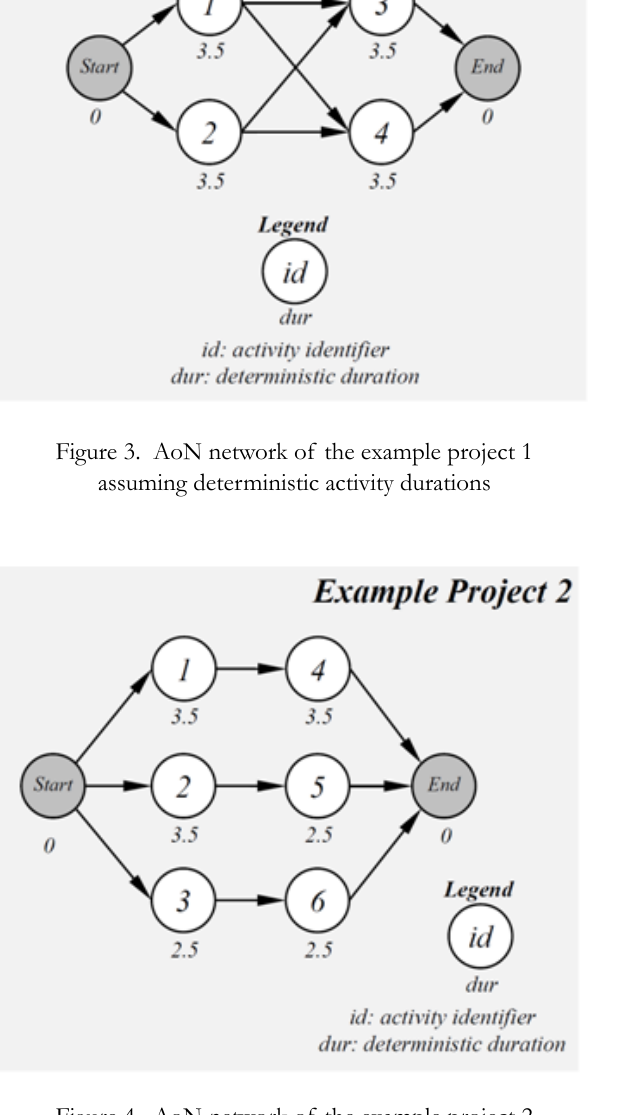
Figure 4. AoN network of the example project